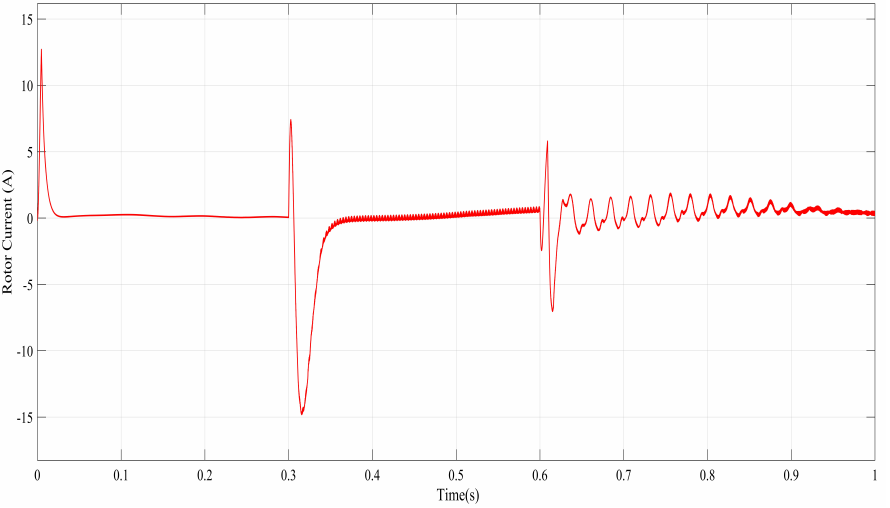
Figure 15. Rotor current response to varying speed.